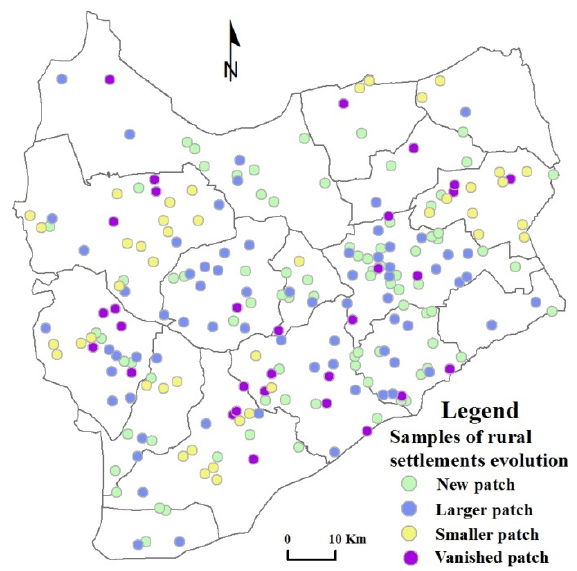
Figure 2. Spatial distribution of the typical patches of changing rural settlements.